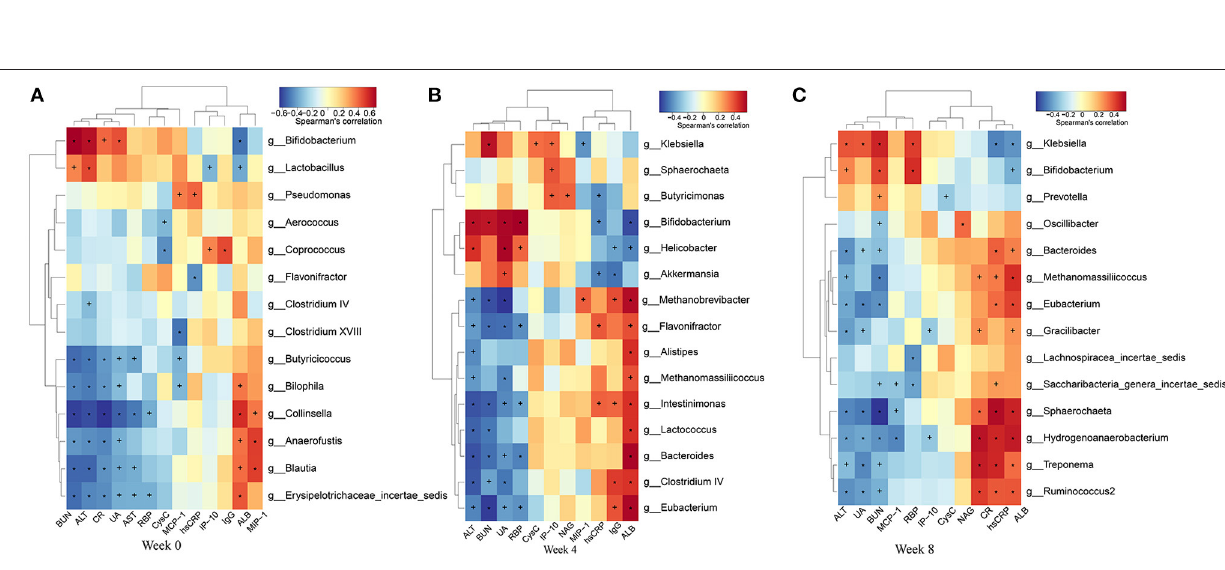
FIGURE 10 | Heatmaps of the correlation coefficients between the phenotypes and the differential microorganisms of the rats in each group at 0 (A) , 4 (B) , and 8 (C) weeks. Coloring indicates the direction of association (red: positive; blue: negative). + P < 0.05; * P <